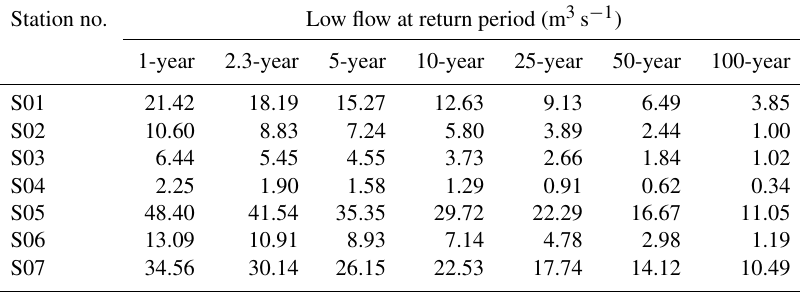
Table 7. The return period of low flow at all streamflow stations. Station no.